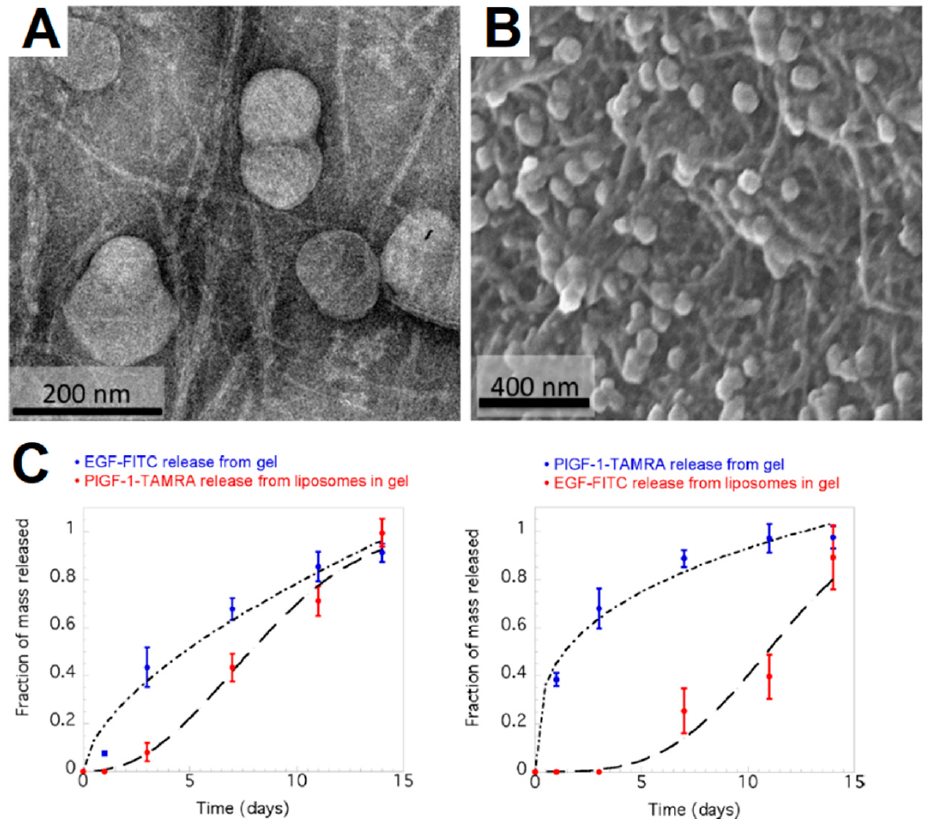
Figure 2. ( A ) Negatively stained transmission electron microscopy and ( B ) scanning electron mi- croscopy images of peptide-based hydrogel containing liposomes. ( C ) Bimodal release profiles of two different growth factors (EGF-FITC and PlGF-1-TAMRA) either loaded in the hydrogel matrix (blue) or encapsulated in liposomes within the gel (red). Adapted from reference [61] with permission from American Chemical Society (ACS), 2022 (Notice to readers: further permissions should be directed to the